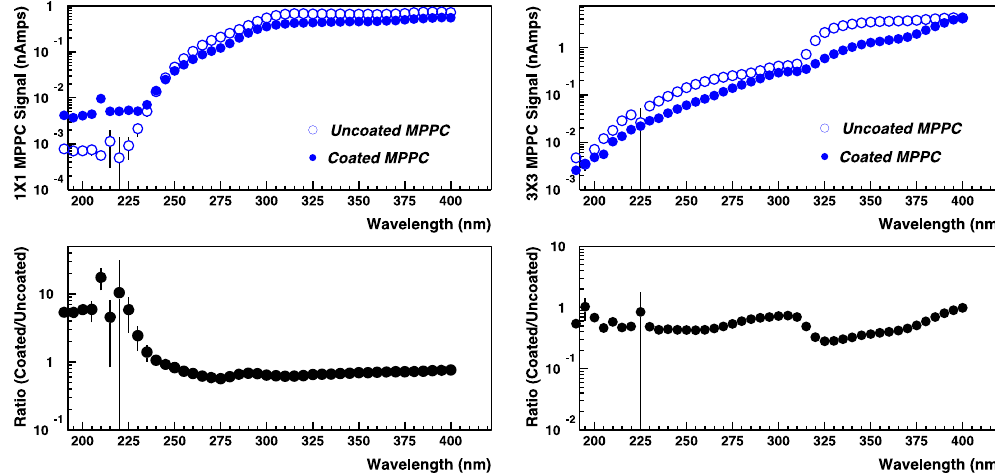
Figure 6. Response of Coated (blue dots) and Uncoated (blue circles) sensors for (top left) 1 mm × 1 mm and (top right) 3 mm × 3 mm MPPCs and corresponding ratios of Coated to Uncoated response (bottom).